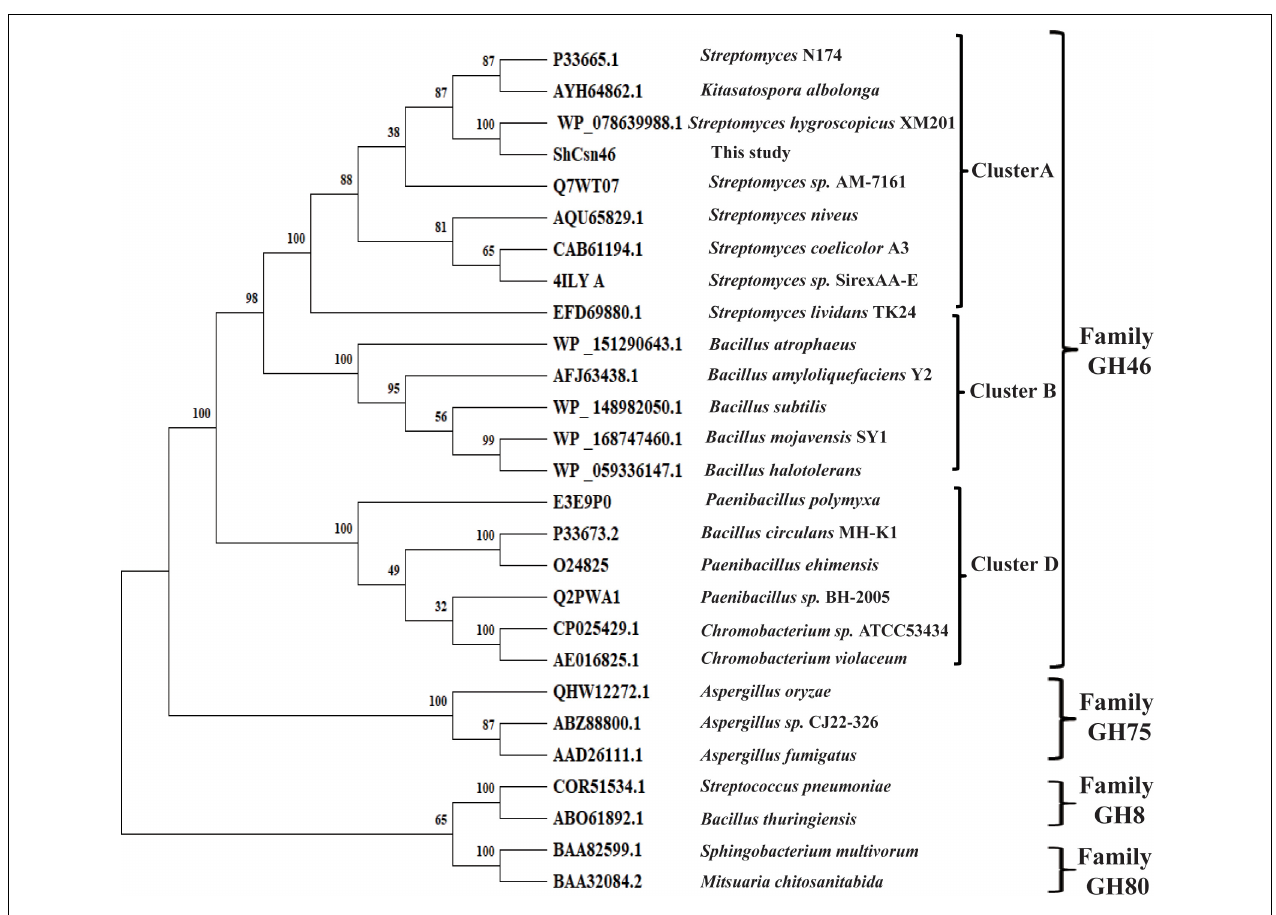
FIGURE 1 | Phylogenetic analysis of Sh Csn46. Different chitosanases from GH8, GH46, GH75, and GH80 family were retrieved from